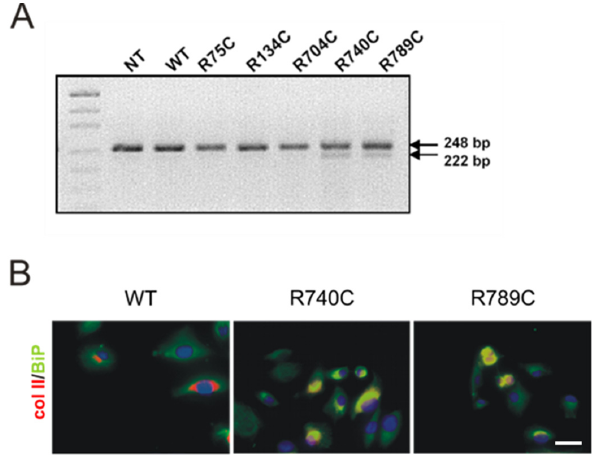
Figure 5. Detection of stress-induced XBP-1 splicing and BiP expression in transfected HT1080 cells. ( A ) mRNA isolated from HT1080 cells was used for RT-PCR with primers specific for XBP-1. The PCR products were separated on 2.5% agarose gels. XBP-1 mRNA (248 bp) could be detected in all cells. Splicing of XBP-1 due to ER stress gives rise to a 222-bp fragment that was seen only in cells transfected with R740C and R789C constructs. ( B ) HT1080 cells transfected with collagen II constructs were analyzed three days post-transfection by staining with antibodies directed against collagen (red) and BiP (green). BiP expression was observed in all the cells. However, increased BiP expression and colocalization with collagen II resulting in strong yellow signals were seen only in cells expressing R740C and R789C collagens. Scale bar, 25 µm.